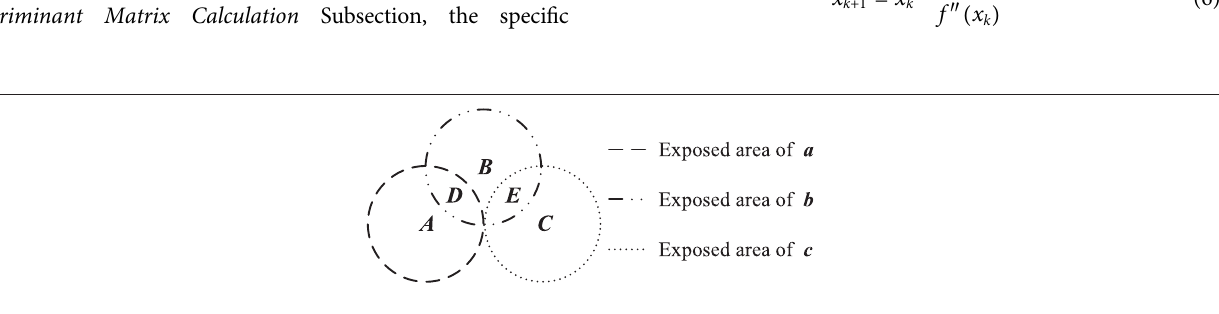
FIGURE 2 | Schematic diagram of economic losses caused by short circuits in different areas.